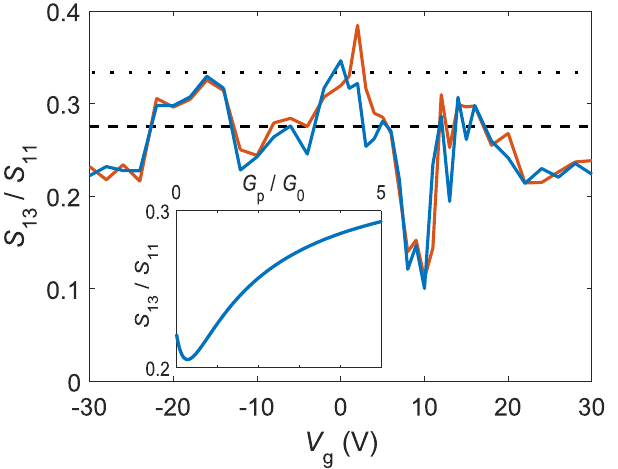
Figure 4. Ratio of S S / vs. V with bias applied via terminal 1 having the other terminals DC grounded. The 13 11 g two data sets, light and dark, relate to V 0 , respectively: their difference is indicative of the small uncertainty in b  = . . Our data deviates from the the data. The dashed line indicates the result from our HCL model with G G / 3 4 p 0 diffusive theory value 1/3 as shown in the dot line. The fluctuations in the data are related to universal noise = fluctuations 30 . The inset displays the calculated behavior of S S / vs . the ratio G G / (at G G / 1 13 11 p 0 p t